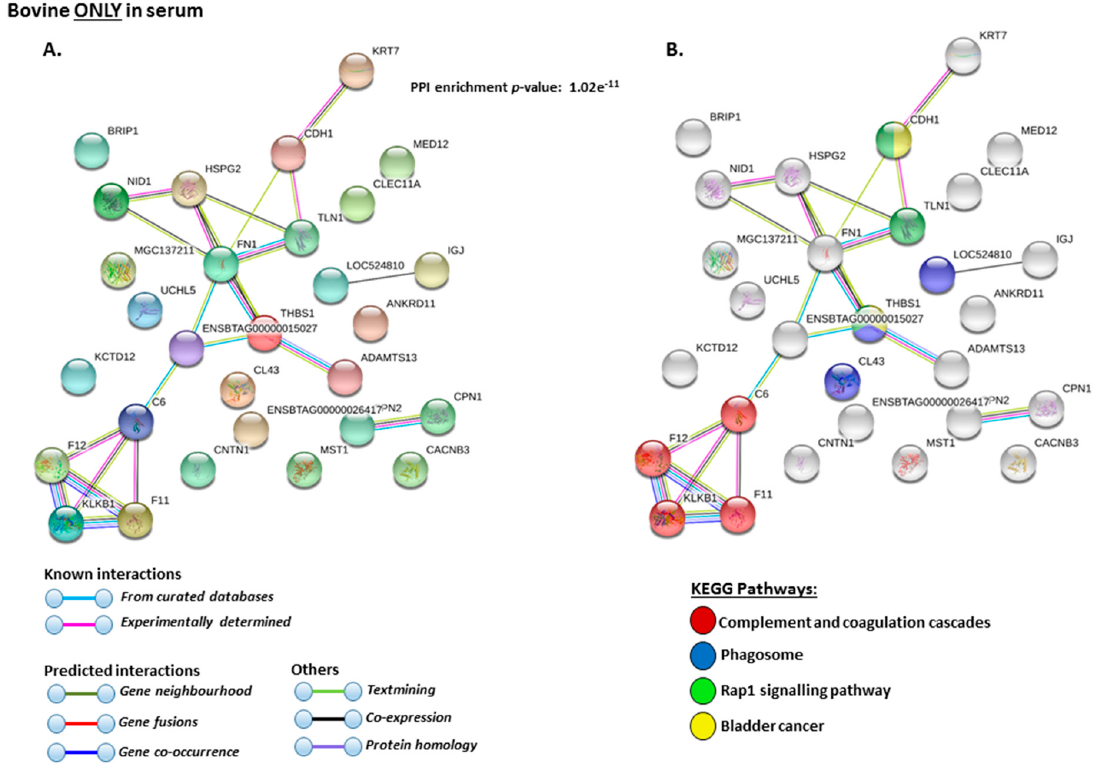
Figure 5. Protein–protein interaction networks of deiminated protein candidates identified in bovine serum only (not identified in EVs). Protein–protein interactions were reconstructed based on both known and predicted interactions by STRING analysis. ( A ) Query proteins are indicated by the coloured nodes and represent the first shell of interactors. ( B ) KEGG pathways reported in STRING and related to the identified proteins are highlighted (see the colour code included in the figure). The coloured lines highlight which protein interactions are identified through known interactions (this refers to curated databases, experimentally determined), through predicted interactions (this refers to gene neighborhood, gene fusion, gene co-occurrence) or through co-expression, text mining or protein homology (the colour key for connective lines is included in the figure).